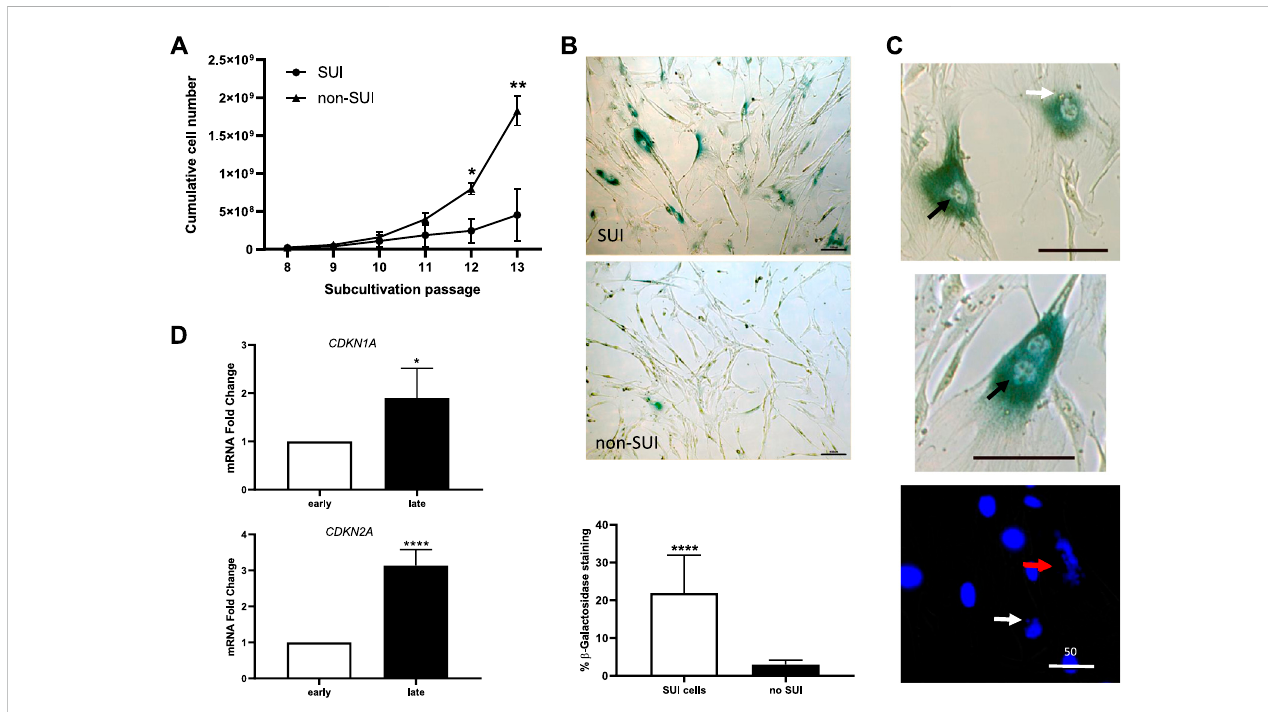
FIGURE 4 Suburethralmyo fi broblasts presented alimitedcell proliferationandprematuresenescence. (A) Cellsfrom SUImyo fi broblastcultures( n =5) ornon-SUI ( n = 3) fi broblast cultures were counted at each passage and the cumulative cell number was determined. Error bars are SD of mean; (* p < .05, ** p < .01). (B) Representative photomicrograph of blue-colored staining for SA- β -gal activity in cells from SUI myo fi broblast cultures or non-SUI cultures. The images correspond to cell passage 9. The graphic represents the percentage ofSA- β -gal positive cells (blue)cells calculated respect to thenumber of totalcells found in 10 and 15 fi elds of SUI ( n = 2) and non-SUI (n = 3) cell cultures, respectively. (C) Analysis of senescence markers in SUI myo fi broblast in early and late passages, 3 and 11, respectively. Change in CDKN1A and CDKN2A mRNA expression ( n = 5). Error bars are SD of mean; (* p < .05, **** p < .0001). (D) High magni fi cation of senescent cells found in SUI cultures, showing irregular nuclei (black arrow, upper panel), blebbing nuclei (white arrow, upper and lower panel), broken cell nucleus (red arrow), or binucleate cells (middle panel). Bar = 100 micras, except where speci fi ed to be 50